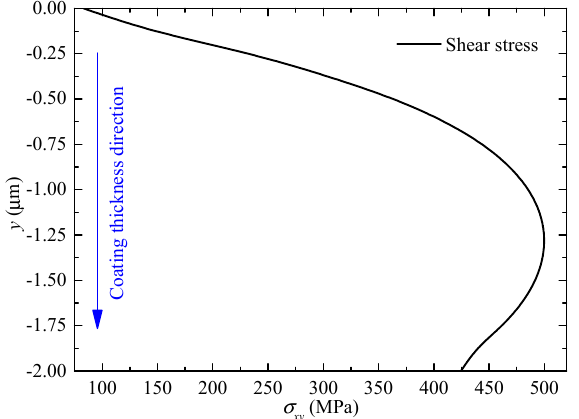
Figure 9. Distribution of shear stress along the coating thickness direction at x = 0.153 mm.